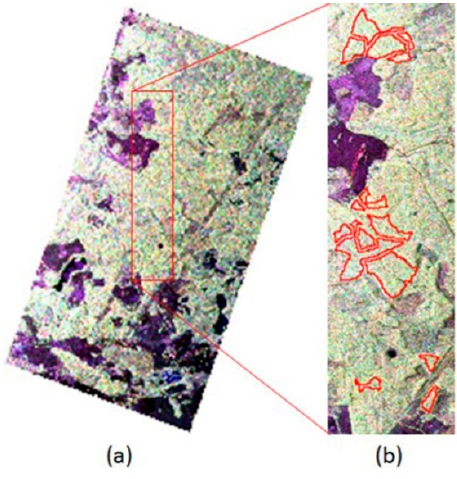
Figure 2. Images of the study area. ( a ) E-SAR image in the Pauli basis, ( b ) selected area (the boundary of the stands has been represented by red closed curves).